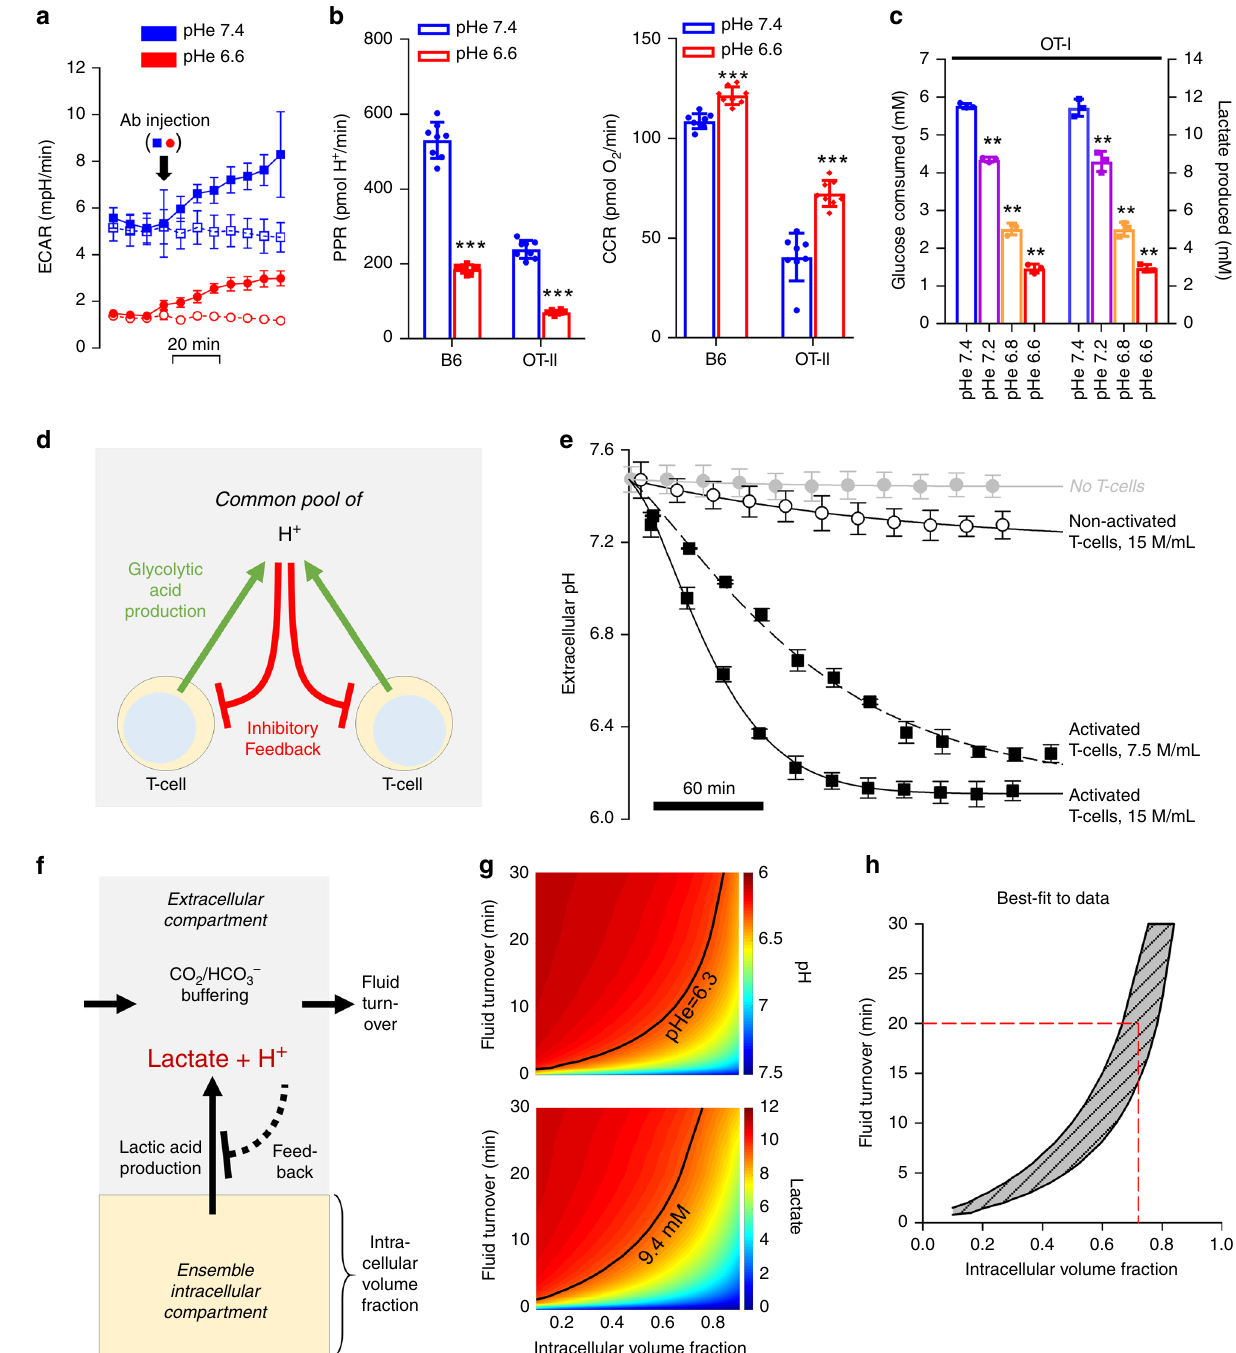
(ECAR), measured by a Seahorse extracellular fl ux (XF) analyser (Fig. 2a). Note that although ECAR was lower in T-cells incu- bated at a lower pH, addition of CD28 Ab increased the glycolytic ECAR at both low and high pH. ECAR can be converted, using data for buffering capacity, to a quantitative H + production rate (PPR) generated by T-cells, 48 h after their activation (Fig. 2b). At pHe 7.4, the PPR of activated T-cells, isolated from B6 mice, was equivalent to ~10 mmoles/min/(L of intracellular volume), after accounting for buffering capacity ( β = 3.78 mM/pH) and intra/ extracellular volume-ratios (chamber volume of 2.28 µL, cell radius cell radius = 5.14 µm, SD = 0.68 µm, number of cells 100,000). This glycolytic rate is high; comparable to the most